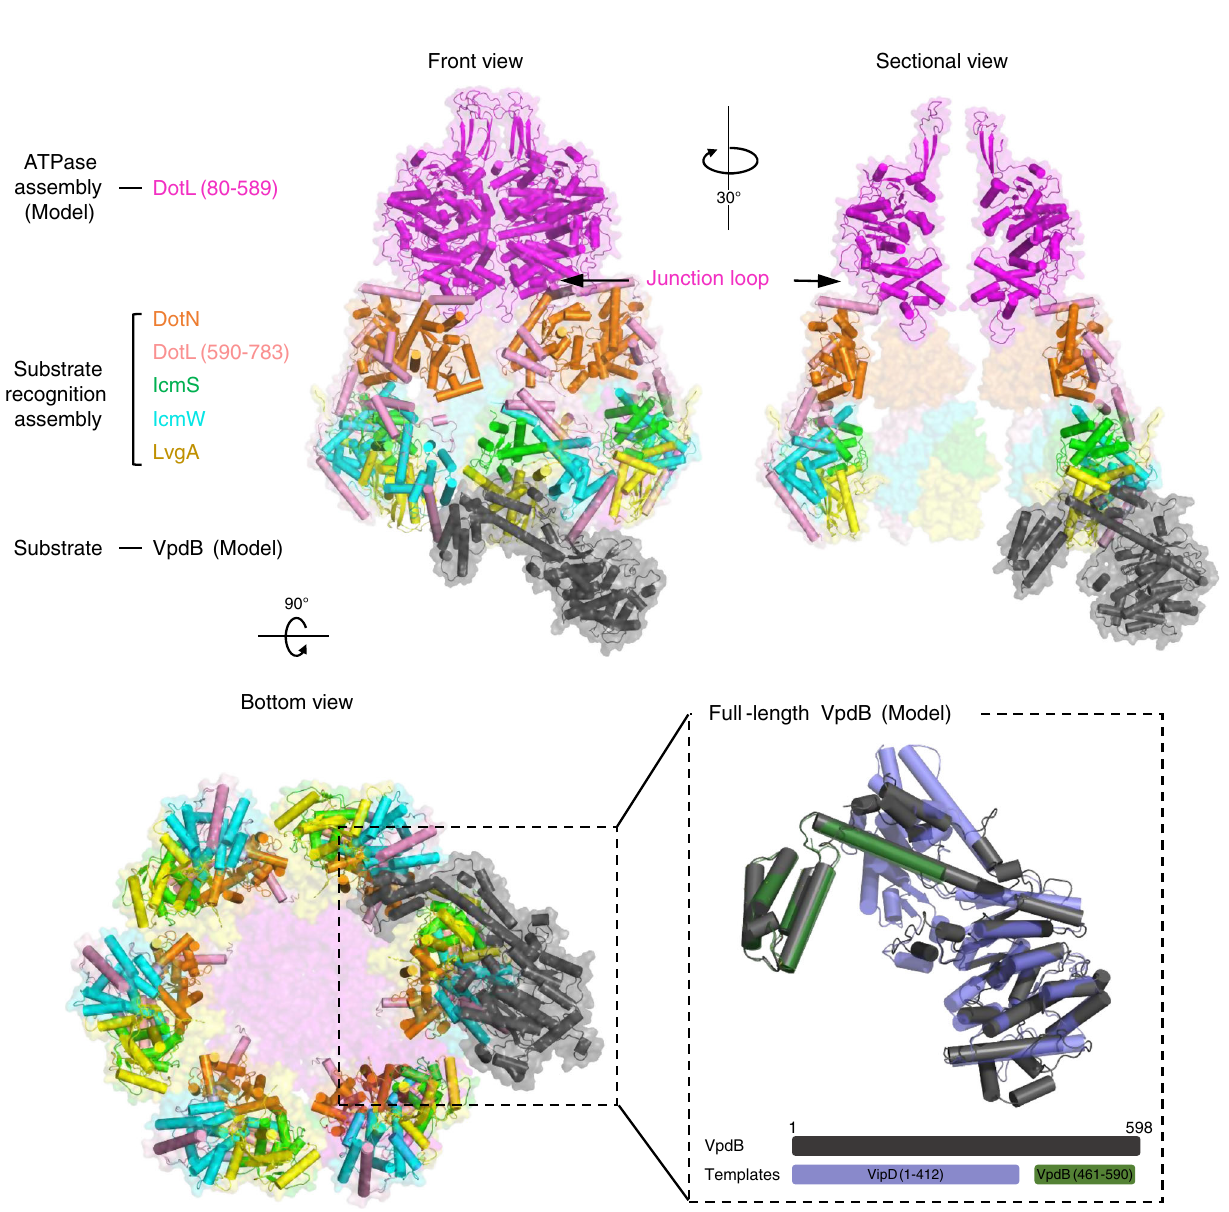
Fig. 5 A model for substrate binding to Dot/Icm T4CP holocomplex. Three different views of the Dot/Icm T4CP holocomplex bound to full-length VpdB are shown. The junction loop between the ATPase assembly and the substrate recognition assembly is indicated, where a hinge bending motion might take place. A model for full-length VpdB built by homology modeling is shown. Each subunit is color coded. The holocomplex model does not include the membrane segment of DotL and the DotM subunit. The Legionella pneumophila Dot/Icm type IVB secretion system (T4BSS) translocates effector proteins into host cells and the recognition of these effectors is mediated by the Dot/Icm type IV coupling protein (T4CP) complex. Here, the authors present the crystal structure of a four-subunit containing T4CP subcomplex bound to the effector protein VpdB and identify a FxxxLxxxK binding motif that is present in a subset of the effectors and which is recognized by the T4CP adaptor subunit